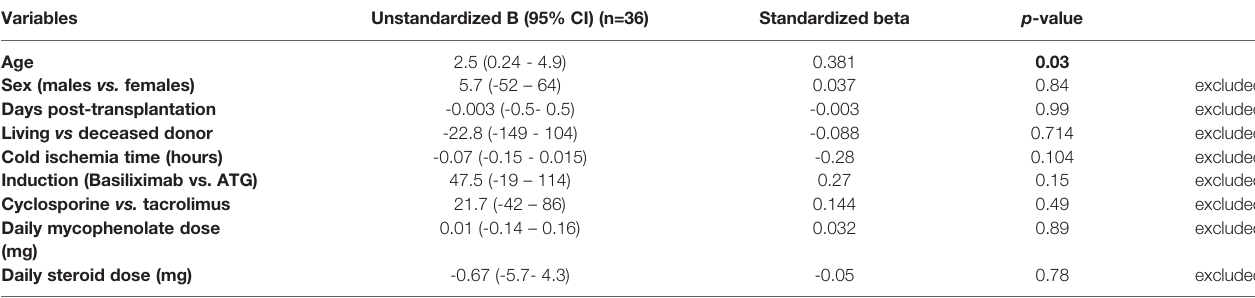
TABLE 7 | Multiple linear regression analysis of the factors affecting absolute CD8+CD28- Treg counts in early renal transplant recipients.